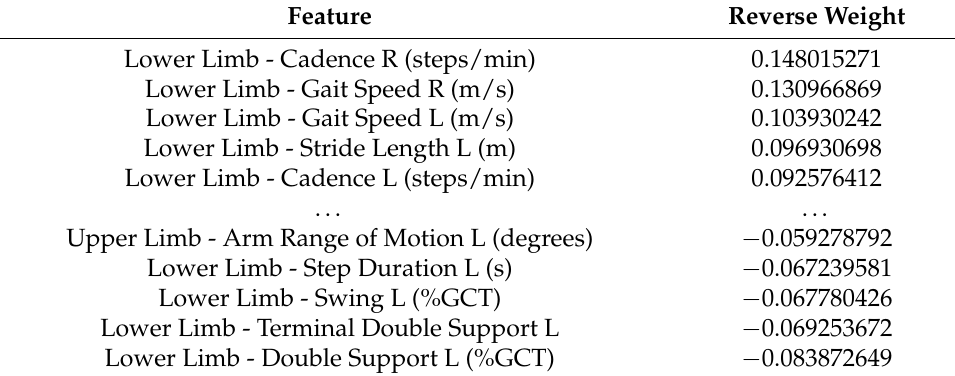
Table 4. Sanity check. RSW input as impact indicator for top-5 and last-5 features [Abbreviations: R = right, L = left, GCT = Gait Cycle